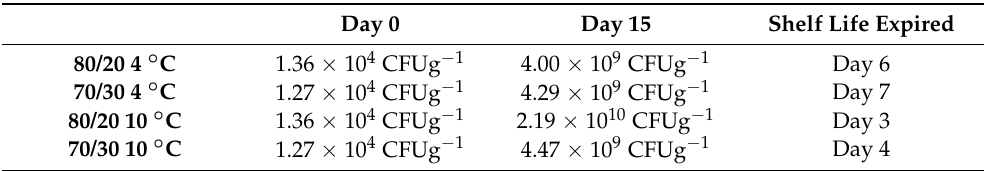
Table 1. TVC for the poultry on days 0 and 15 for each storage condition ( n = 4) and the day the critical limit of 10 7 CFUg − 1 was reached (end of shelf life).